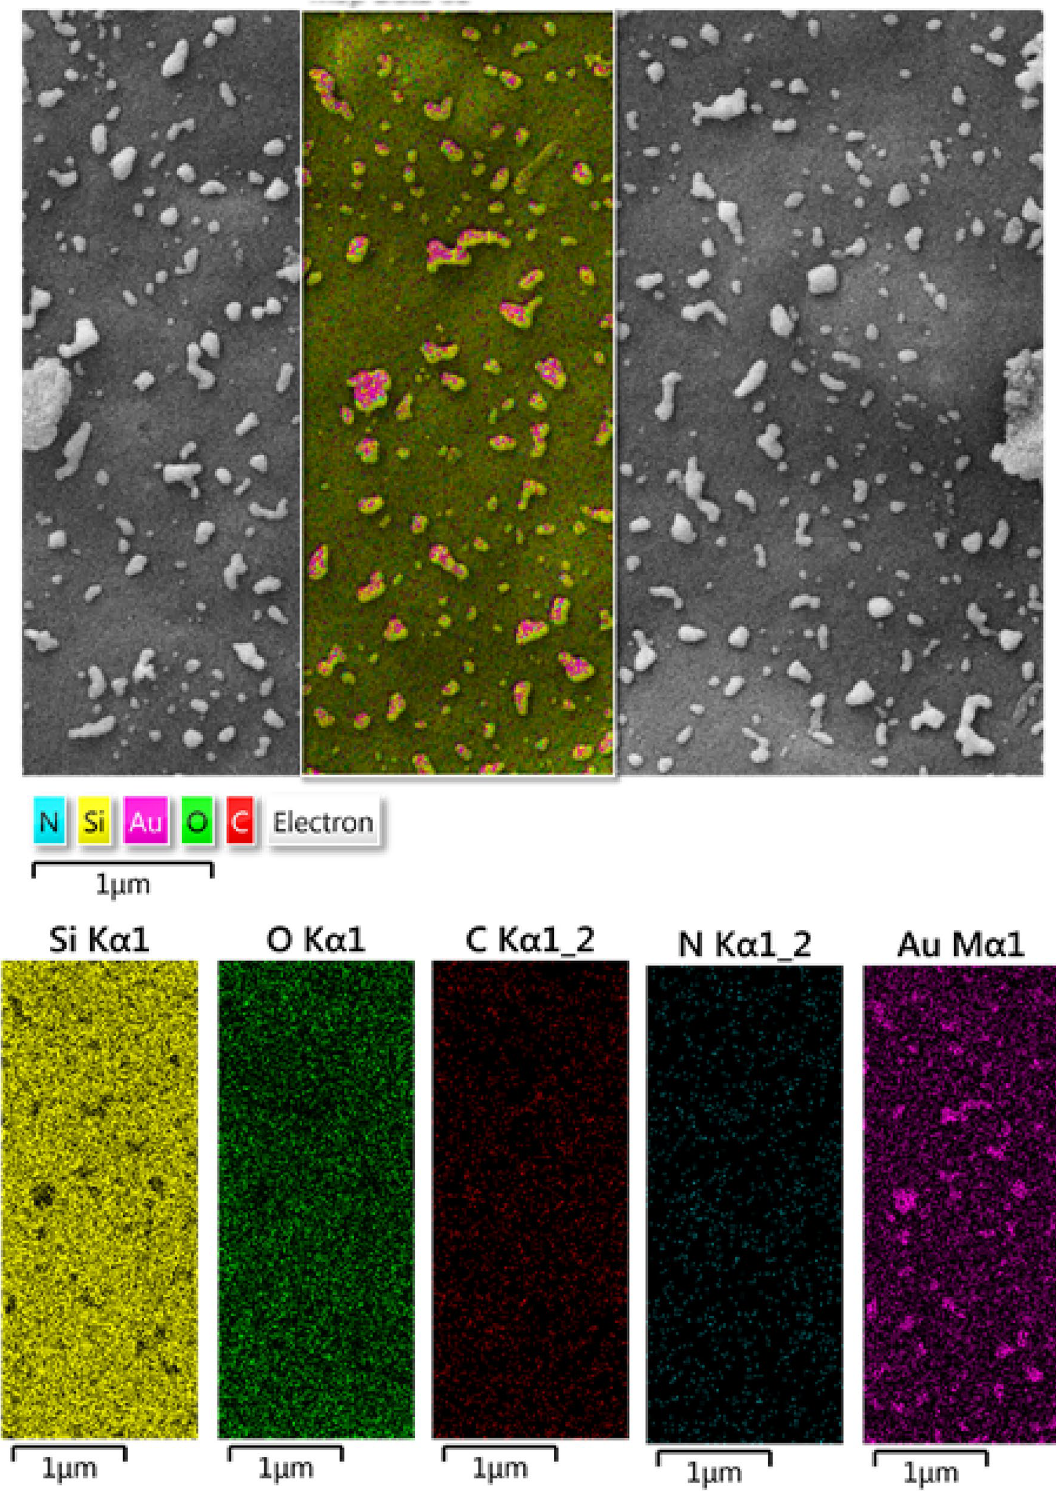
Figure 6. EDS mapping of KIT-5-biguanidine-Au (0)